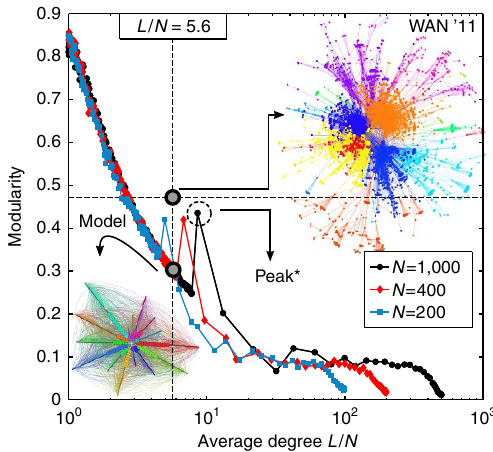
Figure 6 | Modularity as a function of average degree. The model networks show a peak* in the modularity for an average degree close to the World Airline Network. This peak is due to the increase in coreness of the network as the core collapses and a larger core takes shape (see Fig. 5— local peak** observed in the distribution of coreness for modelled networks). For the same average degree, L / N ¼ 5.6, the model generates many interconnected modules while the World Airline Network shows little or no links between modules. Different colours represent different communities and the size of the nodes classify them into core (large) or periphery (small). Data for system sizes N ¼ 200, 400 and 1,000 are averages over 100